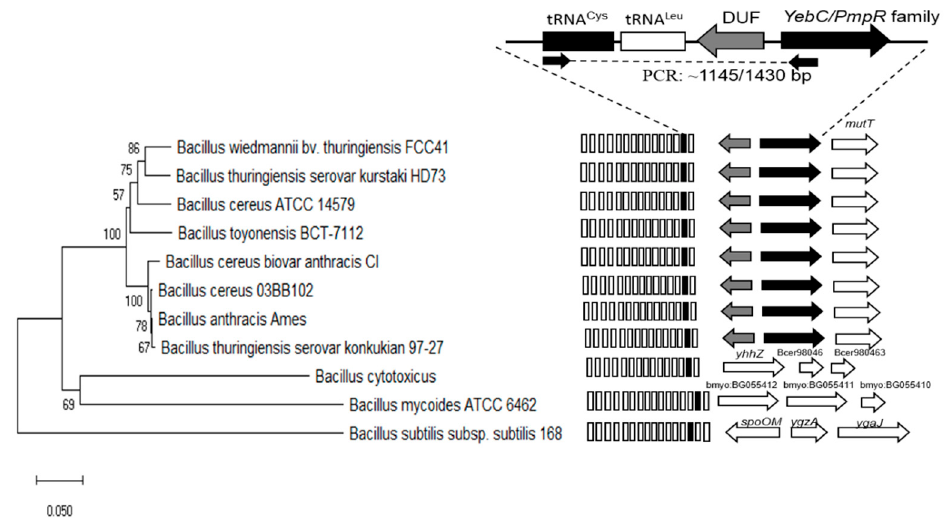
Figure 1. Schematic representation of tRNA Cys -PCR strategy for the B. cereus group. The cluster of 15 to 17 tRNA genes and the orientation of three specific genes located downstream of tRNA Leu is shown. The primers indicated by the arrows were predicted to yield products of 1145 and 1430 bp, respectively (see Methodology). Phylogenetic analysis from these regions were obtained in MEGA X, using the neighbor-joining method. B. subtilis subsp. subtilis 168 was designated as the outgroup taxon.